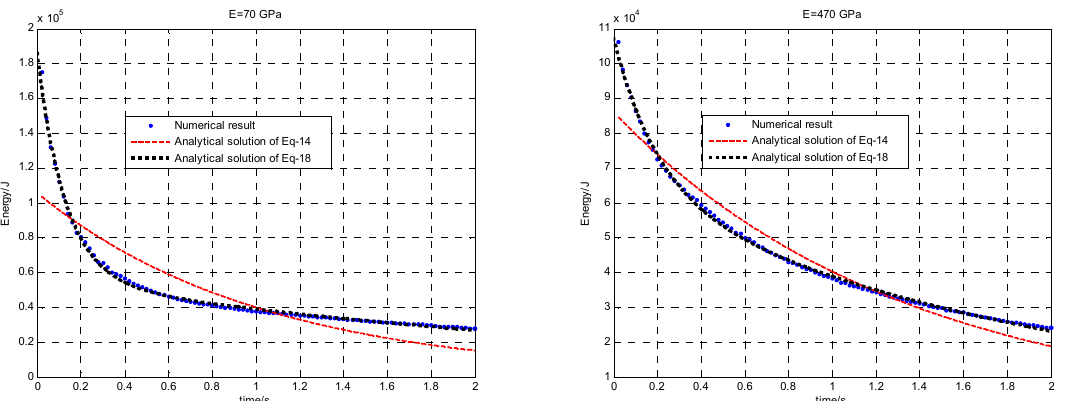
Figure 33. The plot of energy vs. time with E = 70, 470 GPa in case 1, respectively.